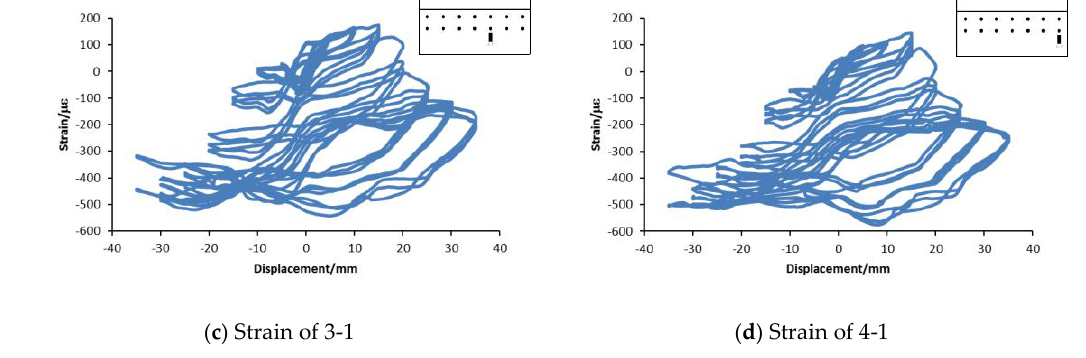
Figure 9. Connector strain curves.